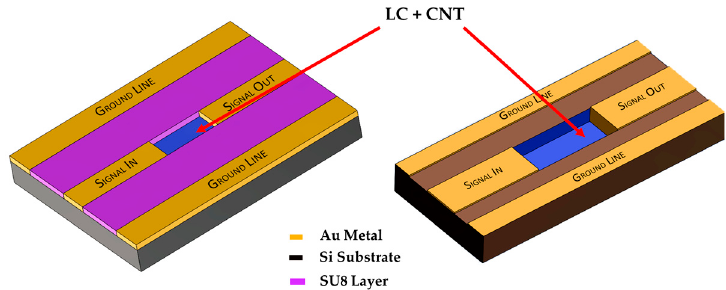
Figure 19. A schematic of two device structures of a coplanar waveguide (CPW) RF device.